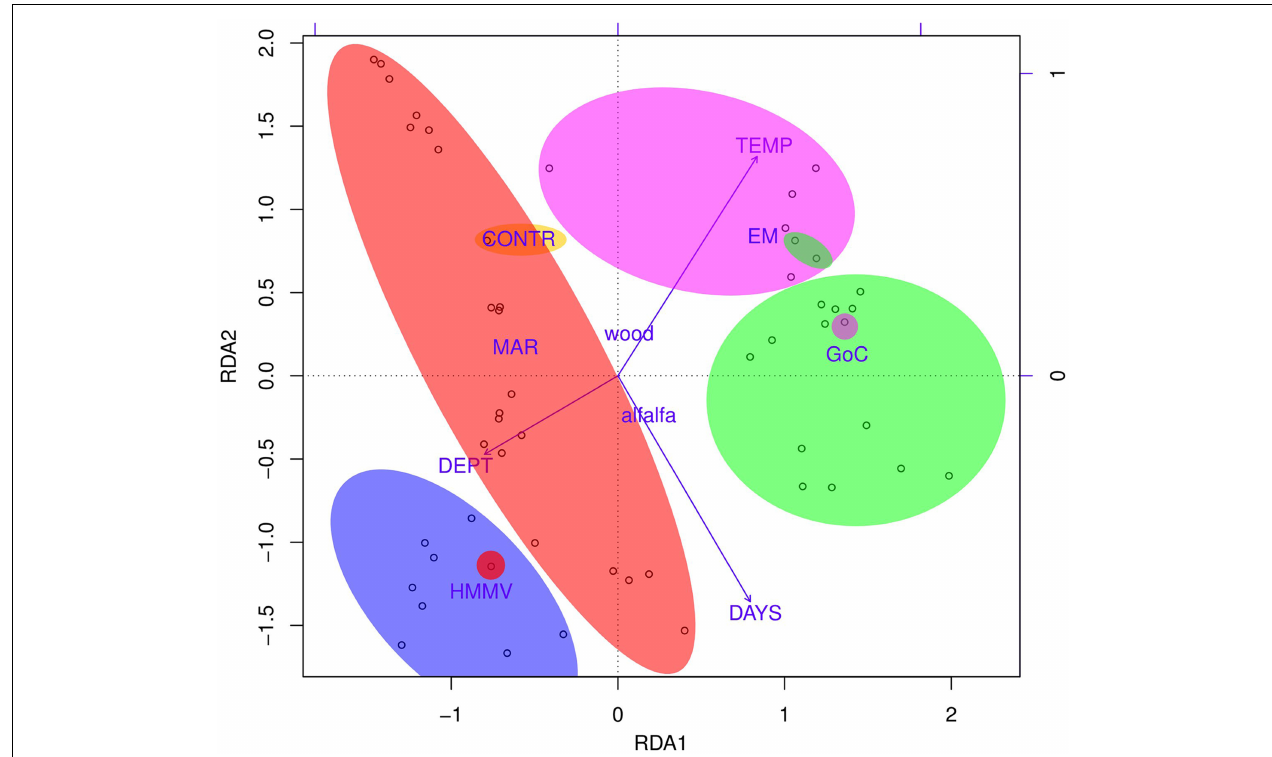
FIGURE 5 | RDA biplot of the Hellinger-transformed OTU abundance data constrained by all environmental variables, scaling 3. Substrate type [factor(SUBS)] and region [factor(REG)] were used as factors and water temperature (TEMP), depth (DEPT), and deployment time (DAYS) were used as variables into the constrained RDA, generated in R using “rda()” and “plot()” functions in “vegan” package. Geographic areas are